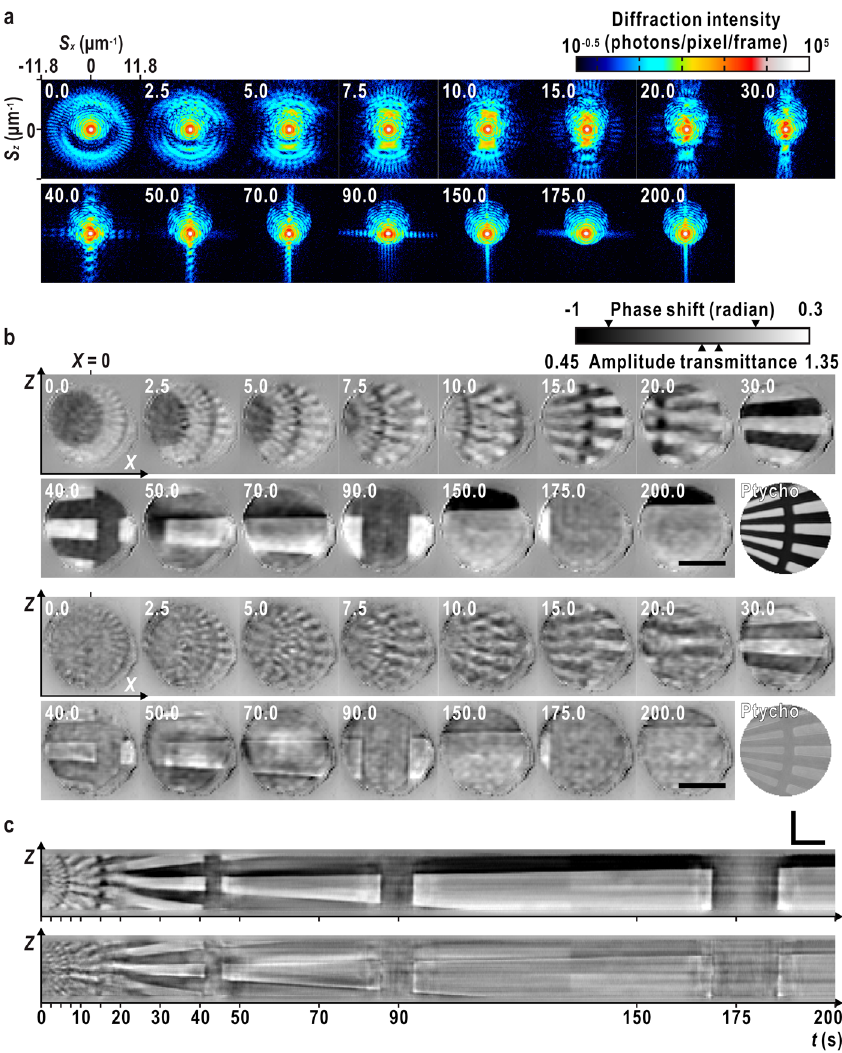
Fig. 10 Proof-of-concept experiment of multiple-shot coherent diffraction imaging. a Selected frames of observed diffraction patterns. The elapsed time of each frame is indicated in seconds. The colour scale is shown at the top. b Phase (upper) and absorption (lower) contrast object frames reconstructed by multiple-frame ptychographic iterative engine with total-variation regularisation (mf-PIE-TV). The frames corresponding to the diffraction patterns in a are shown. Parts of the phase and absorption image of the object reconstructed by ptychography (Fig. 9) are also shown with label “ Ptycho ” for comparison. c Phase (upper) and absorption (lower) contrast spatio-temporal image of the object at horizontal centre of fi eld-of-view (FOV) ( X ¼ 0 in b ). The elapsed time point of each frame in a , b is indicated at the bottom. The grayscale for ( b , c ) is shown at the top of ( b ) with arrowheads indicating the theoretically expected contrast. Both horizontal and L-shaped scale bars indicate 1 μ